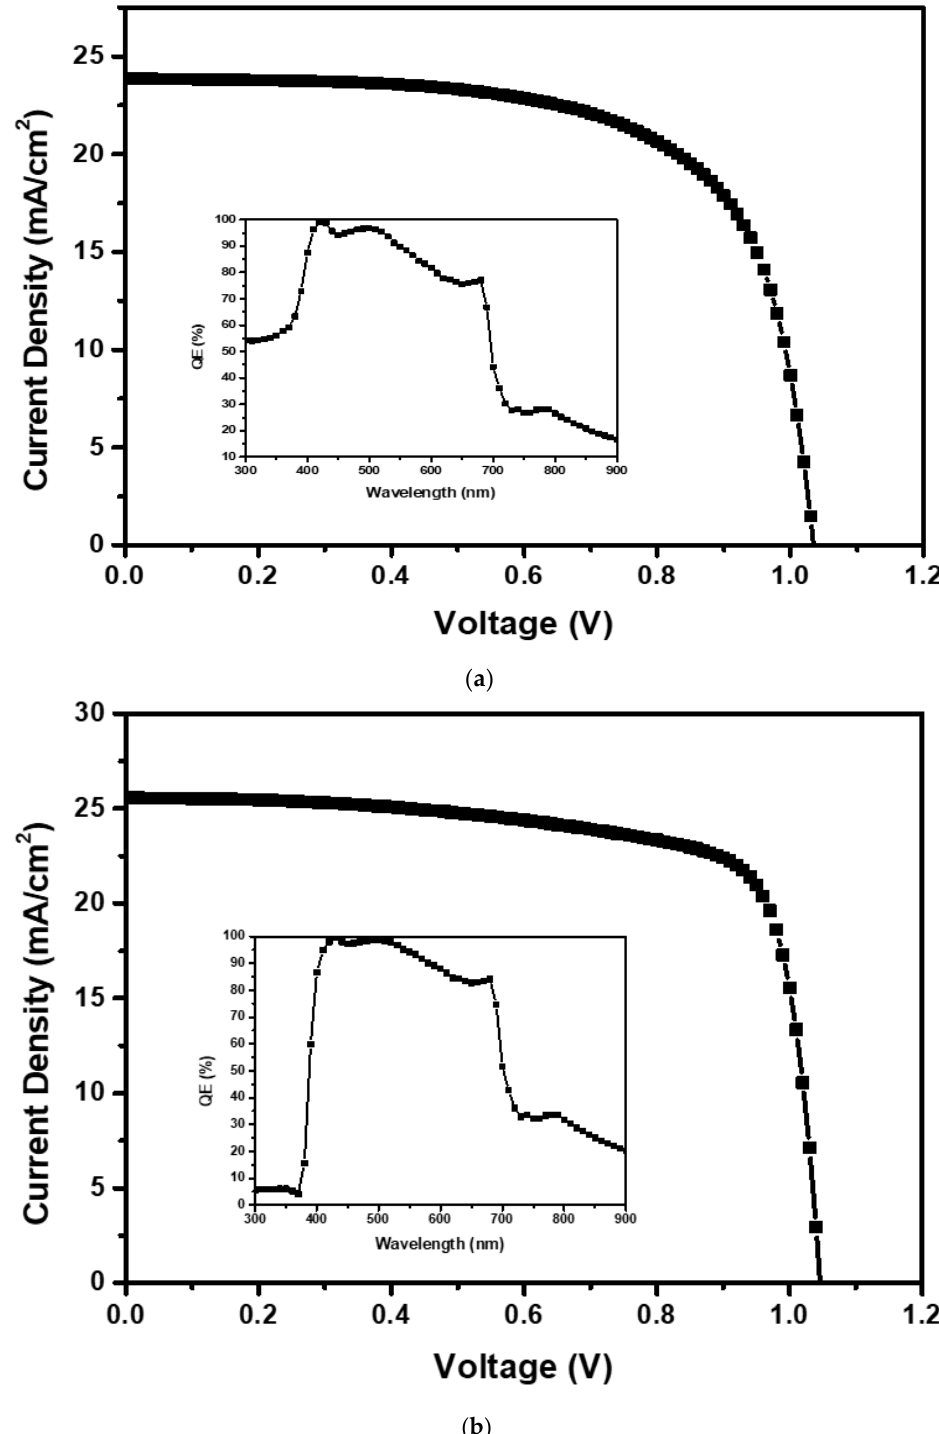
Figure 7. Current density–voltage ( J–V) and QE curves ( a ) before and ( b ) after thickness optimization.